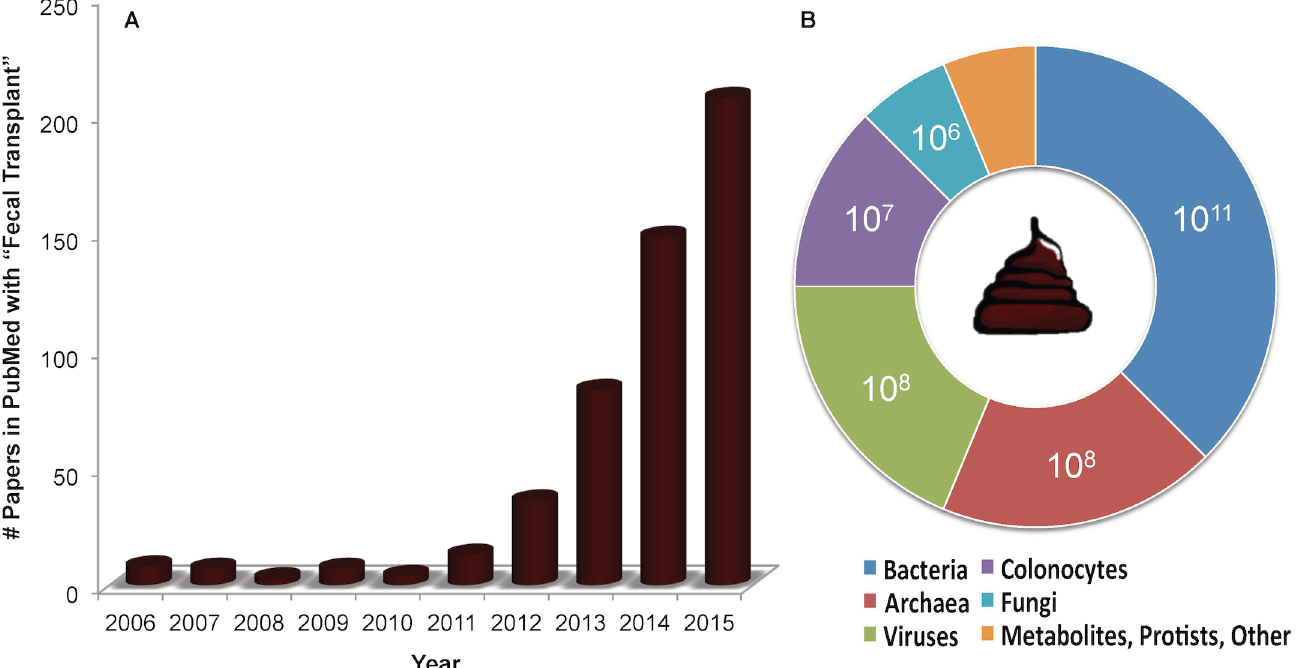
Fig 1. The growth of fecal transplants as reflected in references in PubMed and the estimated composition of human feces. The charts show (A) the rapid rise in publications on fecal transplants in the National Library of Medicine's search service (PubMed), particularly between 2012 and 2015, and (B) the estimated upper concentration of the biological entity per gram of unprocessed human feces, as cited in the text. Estimates do not necessarily reflect the viable number of the biological entity, and the concentration of the archaea is estimated from a methanogen breath test that is not solely based on the presence of archaea. Concentrations of metabolites, protists, and other entities were not